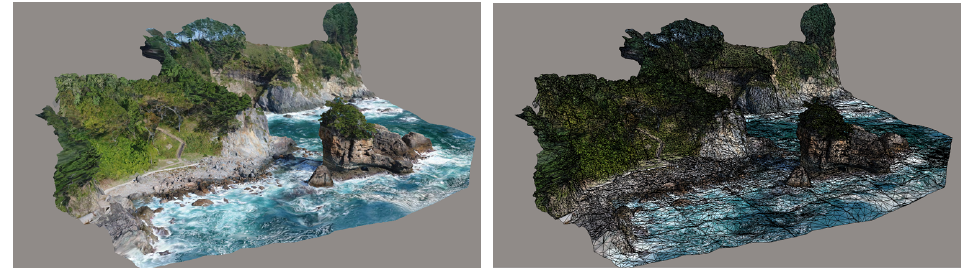
Figure 7. Point cloud data and triangle model.